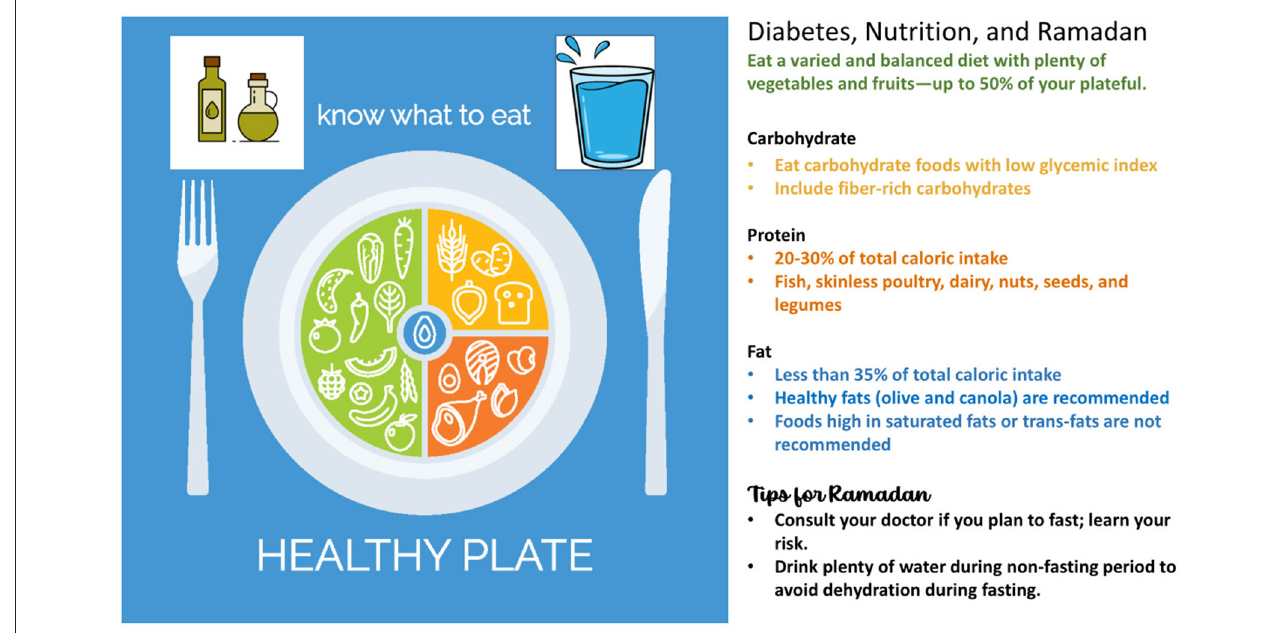
FIGURE 2 | A healthy eating plate to guide dietary intake. Figure information sources (32, 42) with healthy plate image from istockphoto.com.